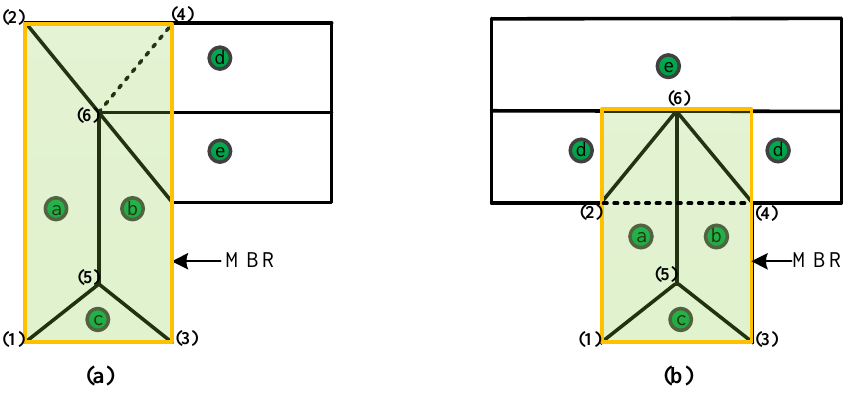
Figure 8. The generation of initial 3D primitives using MBRs and the corresponding planar patches. ( a ) The generation of initial 3D primitives with concave shapes; and ( b ) the generation of initial 3D primitives with convex